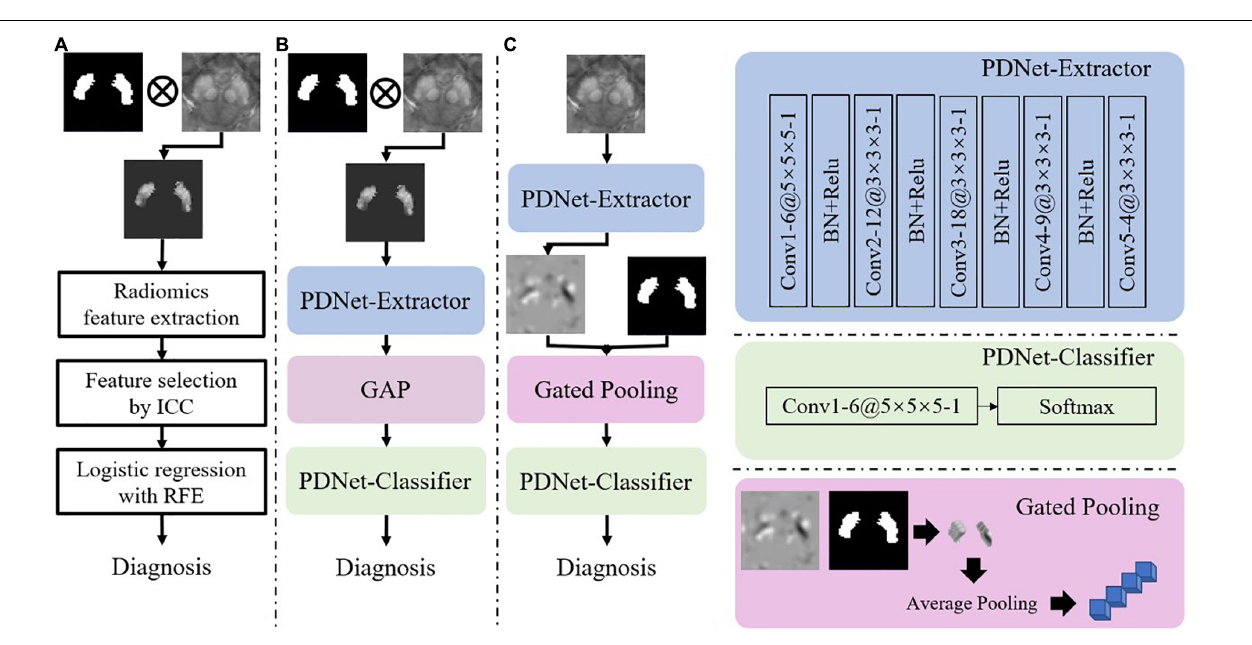
FIGURE 4 | Illustrations of implementation schemes for feature extraction and classification for PD/HC diagnosis. (A) Radiomics features + LR: features are extracted from QSM images with SN labels (ICC: intraclass correlation coefficient, RFE: recursive feature elimination). (B) PDNet: a deep learning network consisting of feature extractor and classifier, which are further detailed in the right panel of the figure. (C) PDNet + Gated Pooling: the Gated Pooling operation is integrated with PDNet, which is also detailed in the right-bottom of the figure, for better classification performance. “Conv”, “BN” and “GAP” stand for convolution, batch normalization, and global average pooling, respectively, in the figure. The number of channels (e.g., 6), kernel size (e.g., 5 × 5 × 5), and stride (e.g., 1) in each convolution layer of PDNet are shown as “6@5 × 5 × 5 -1”.